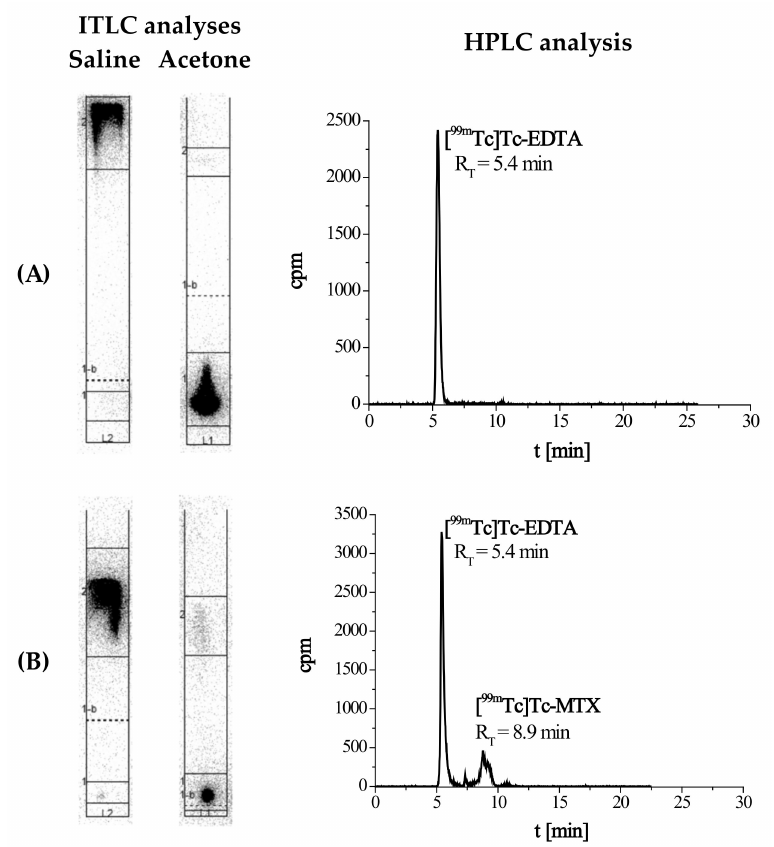
Figure 5. TLC and HPLC analyses verifying formation of ( A ) intermediate [ 99m Tc]Tc-EDTA